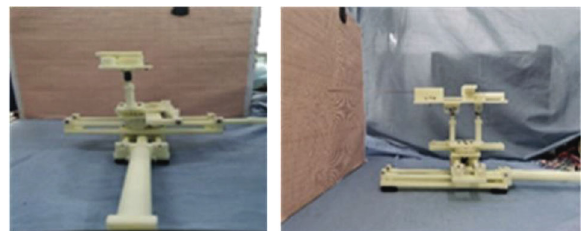
Figure 19: Set the zero point coordinates of the